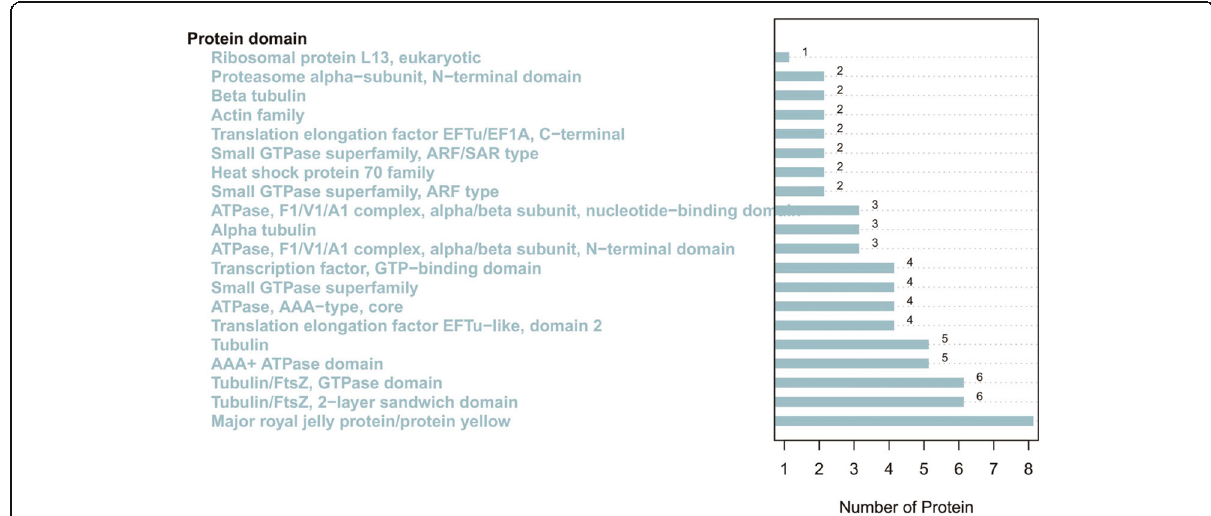
Fig. 5 InterPro protein domain classification of proteins identified in Fraction 2